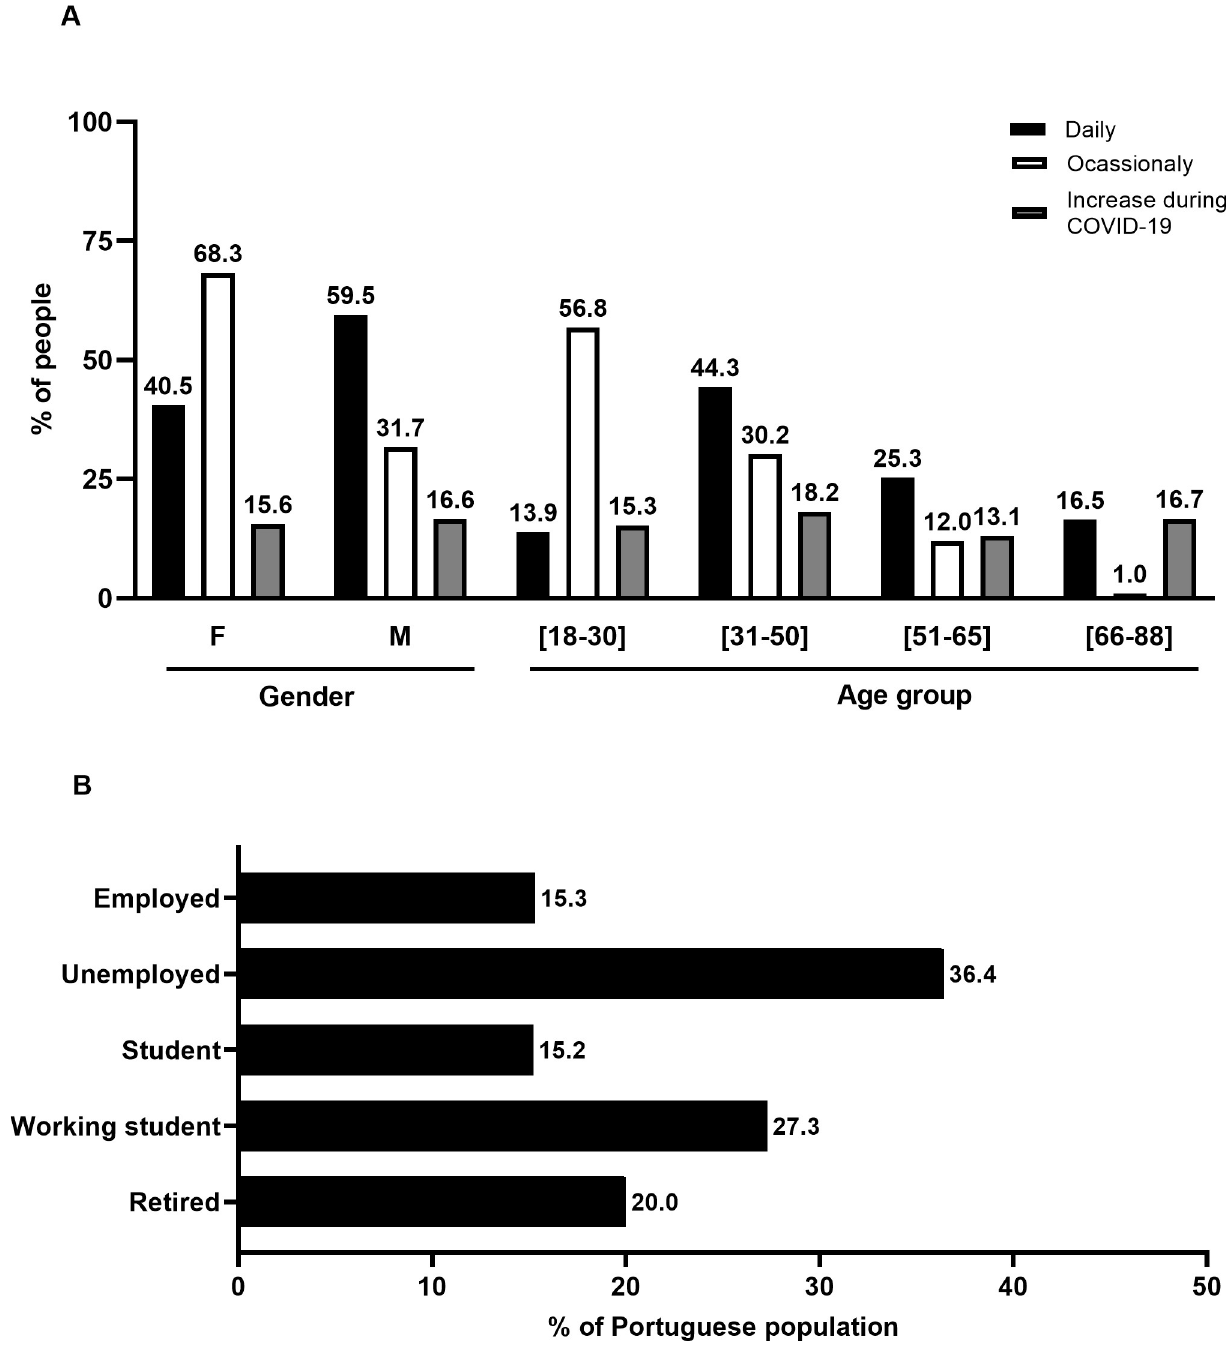
Fig 2. A. Consumption habits of alcohol in the Portuguese population. (A) Consumption of alcohol in the sample; the black bars correspond to the daily consumption while the white bars correspond to occasional consumption; the grey bars refer to the increase of alcohol consumption during the COVID- 19 pandemic. The Y axis represents the percentage (%) of people; the individuals’ values are above each bar. The X axis represents the groups’ analysis (gender: female (F) and male (M) and age group). B. Consumption habits of alcohol in the Portuguese population. (B) Characterisation of people that increased their consumption of alcohol by employment status. The Y axis represents employment status, and the X axis represents the percentage (%) of people that increased their alcohol consumption.